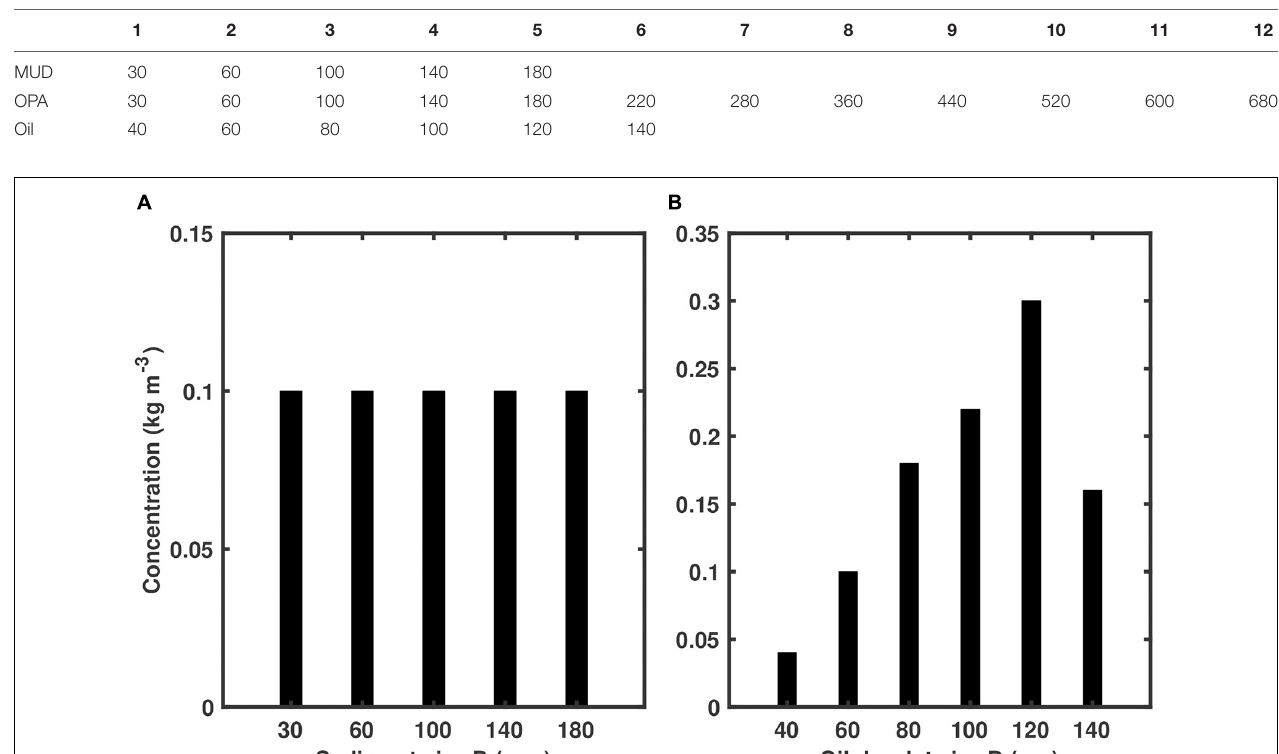
Frontiers in Marine Science |